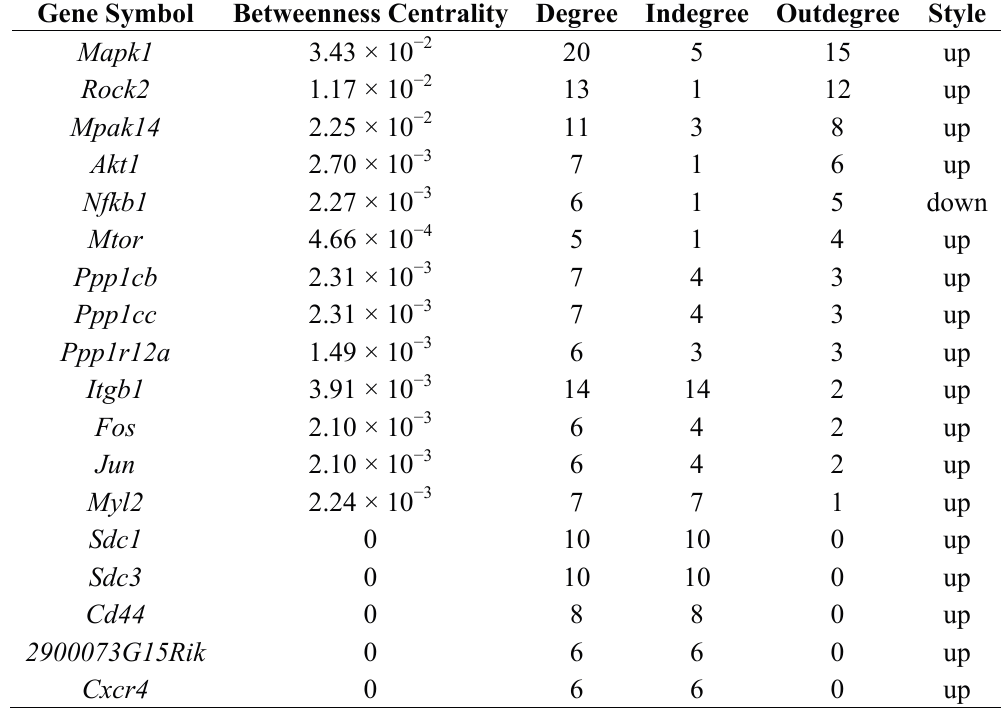
Table 1. Key genes (Degree ≥ 5) of Signal–Net